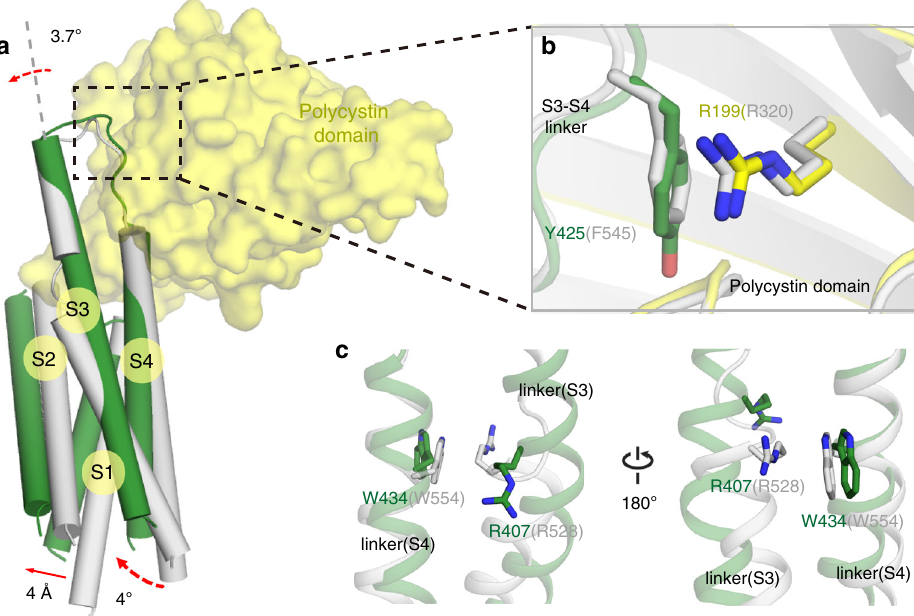
Fig. 4 Outward movements of the overall VSD modeled in PKD2L1. a The VSD domain of PKD2L1 (green) has an outward movement compared to that of the homologous PKD2L1 closed-state model (gray; the modeled structure from PKD2 structure 5T4D), as indicated by red full arrows or dotted arrows. b , c The helix-turn formed by the PKD2L1 S3 – S4 linker appears to exhibit a small-angle rotation ( c ) around a cation- π axis ( b ) by comparing the two PKD2L1 states. Cation – π interactions are formed between R199/Y425 in PKD2L1 and remain stable in both the open-state cryo-EM structure and the closed-state PKD2L1 model (resp. R320/F545 in PKD2). c A cation – π interaction within the S3 – S4 linker (R407/W434 in PKD2L1; R528/W554 in PKD2) is disrupted during the small-angle rotation from closed to open conformation. This process may change the orientation of S3 and S4 helices and may further effect the overall arrangement of the VSD and pore